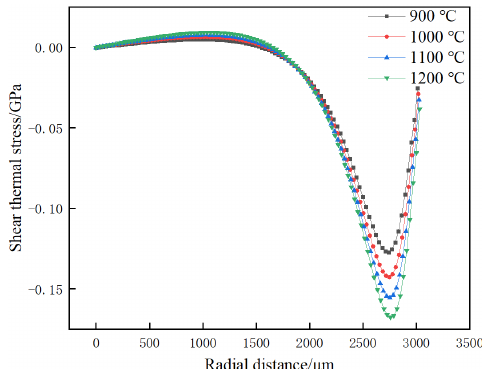
Figure 6. Relationship between the maximum radial thermal stress on the surface of the LMA layer of the ( a ) M1 and ( b ) M2S1 specimens and the operating temperatures. Figure 7. Comparison of the shear thermal stress distribution on the surface of the LMA layer of the M2S1 specimen at four operating temperatures.